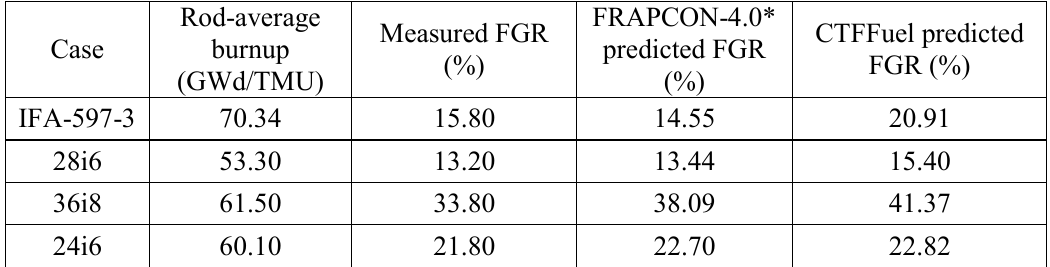
Table I: Steady-State UO 2 FGR Verification Cases.